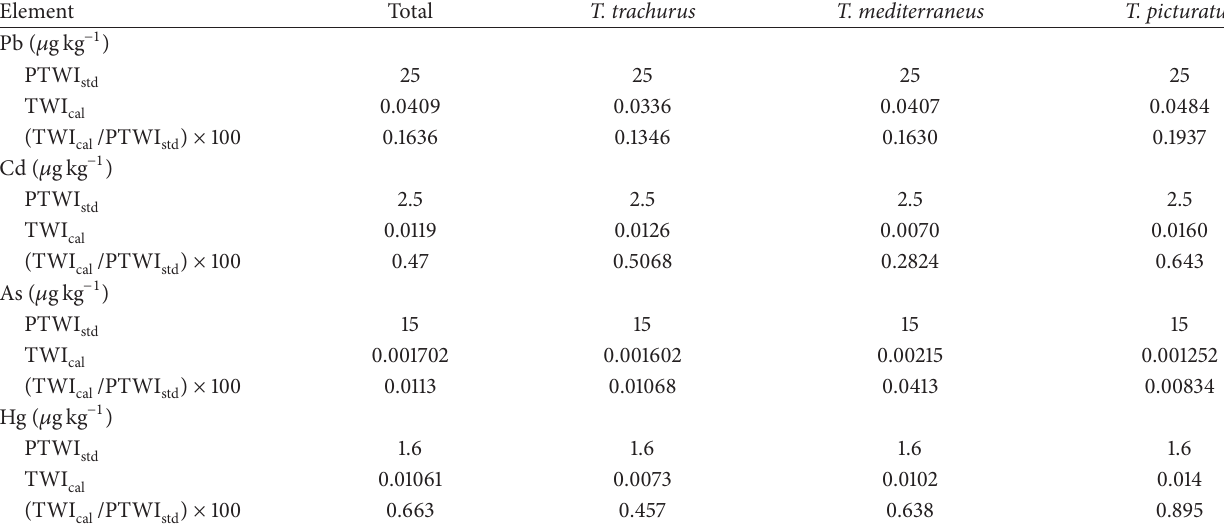
Table 5: Accumulation level of metals in humans due to consumption of studied fish week − 1 Kg −1 body wt. Element